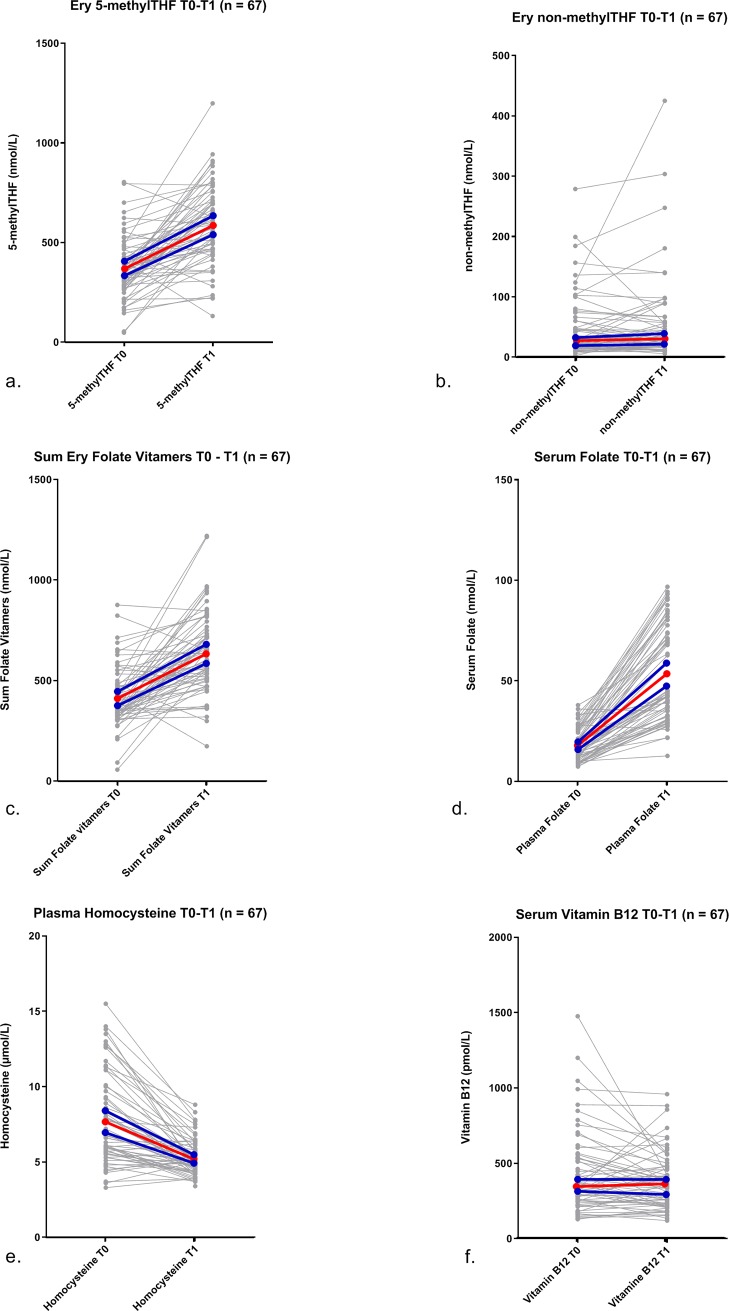
One carbon metabolism metabolite levels before (T0) and after (T1) high-dose MTX therapy.One carbon metabolism metabolite levels before (T0) and after (T1) of high-dose MTX therapy: erythrocyte 5-methyl THF (a, p<0.0001), erythrocyte non-methyl THF (b, p = 0.676) sum erythrocyte folate isoforms (c, p<0.0001), serum folate (d, p <0.0001), plasma homocysteine (d, p<0.0001), serum vitamin B12 (e, p = 0.134). The red lines depict the median levels and the blue lines depict the 95% confidence interval.